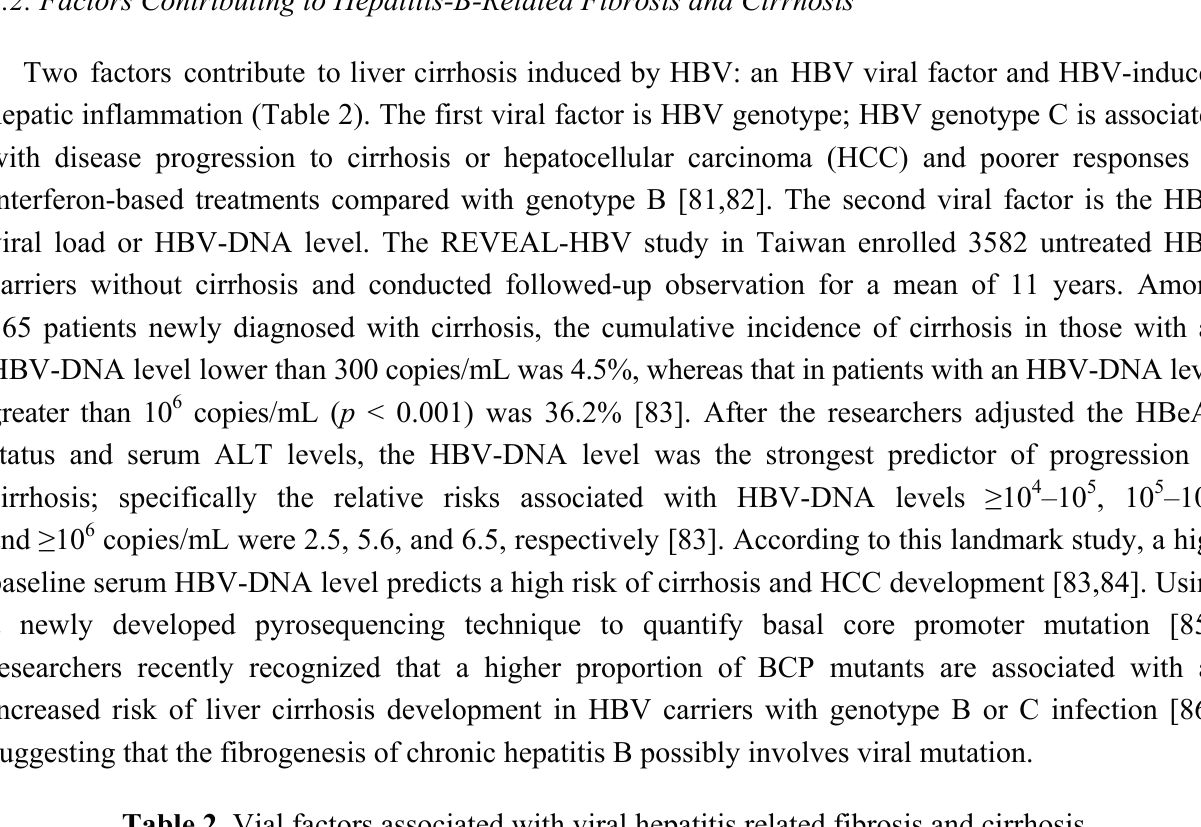
Table 2. Vial factors associated with viral hepatitis related fibrosis and